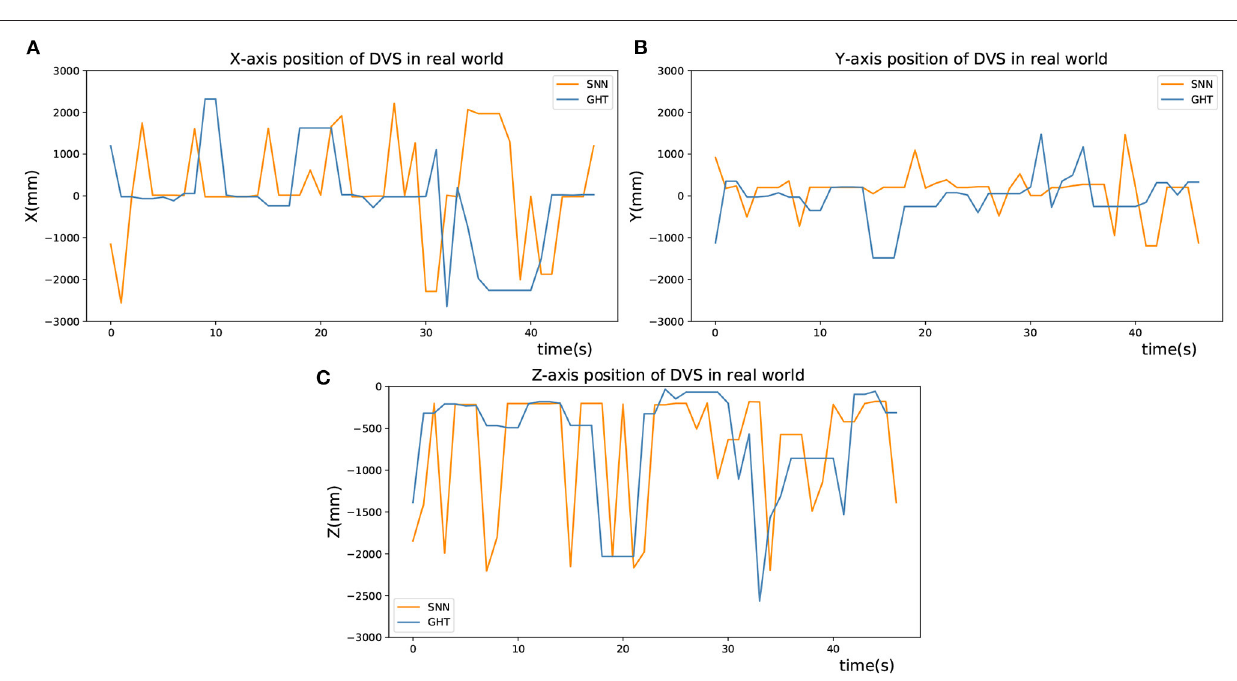
Frontiers in Neurorobotics |